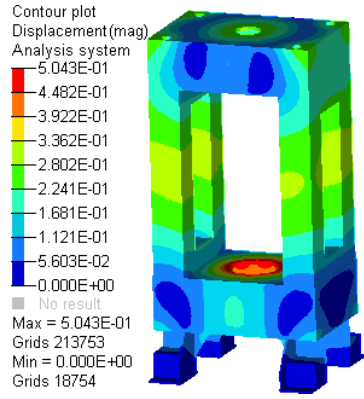
Figure 9. Effective